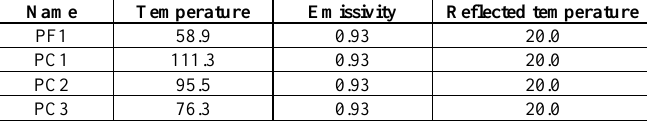
Figure 2: Burns on solar module caused by severe hot spots. Table 1: Markers referring to the analysis of Figure 2.